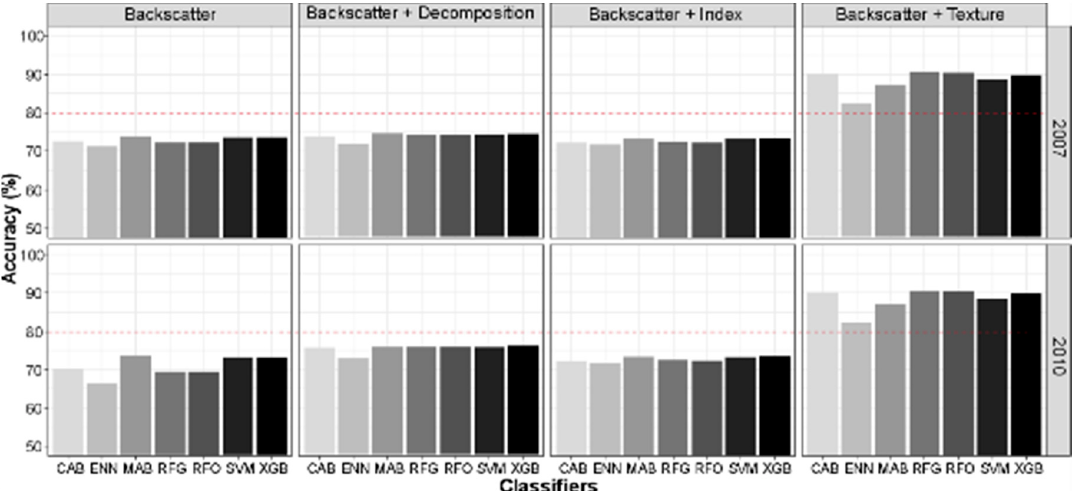
Figure 7. Comparing the accuracy of classification from backscatter intensity and synthetic data amendment, which includes decomposition entropy alpha, radar vegetation index and two parameters of texture Grey Level Co ‐ occurrence Matrix, i.e., mean and variance resulting from seven classifiers including Bagged Classification and Regression Tree (CAB), Extreme Learning Machine Neural Networks (ENN), Bagged Multivariate Adaptive Regression Spline (MARS), Original Random Forest (RFO), and Regularised Random Forest (RFG), Support Vector Machine (SVM) and Extreme Gradient Boosting Tree (XGB).